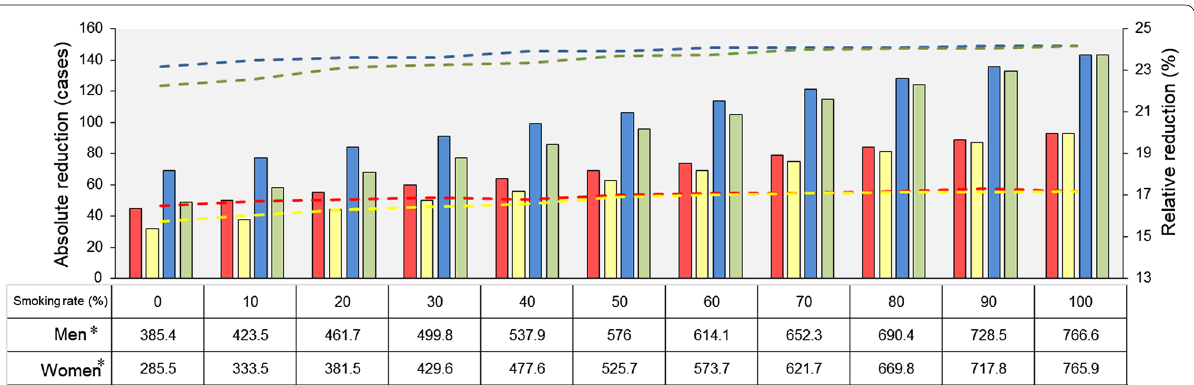
Fig. 3 Reductions in lung cancer deaths with low-dose CT screening over chest X-ray screening and no screening among men and women of 45–80 years old with different proportions of smokers. Bars represent absolute reduction in deaths; dotted lines represent relative reduction in deaths. Red low-dose CT over chest X-ray screening for men, yellow low-dose CT over chest X-ray screening for women, blue low-dose CT over no screening for men, green low-dose CT over no screening for women. Asterisk lung cancer prevalence among the screened population, per